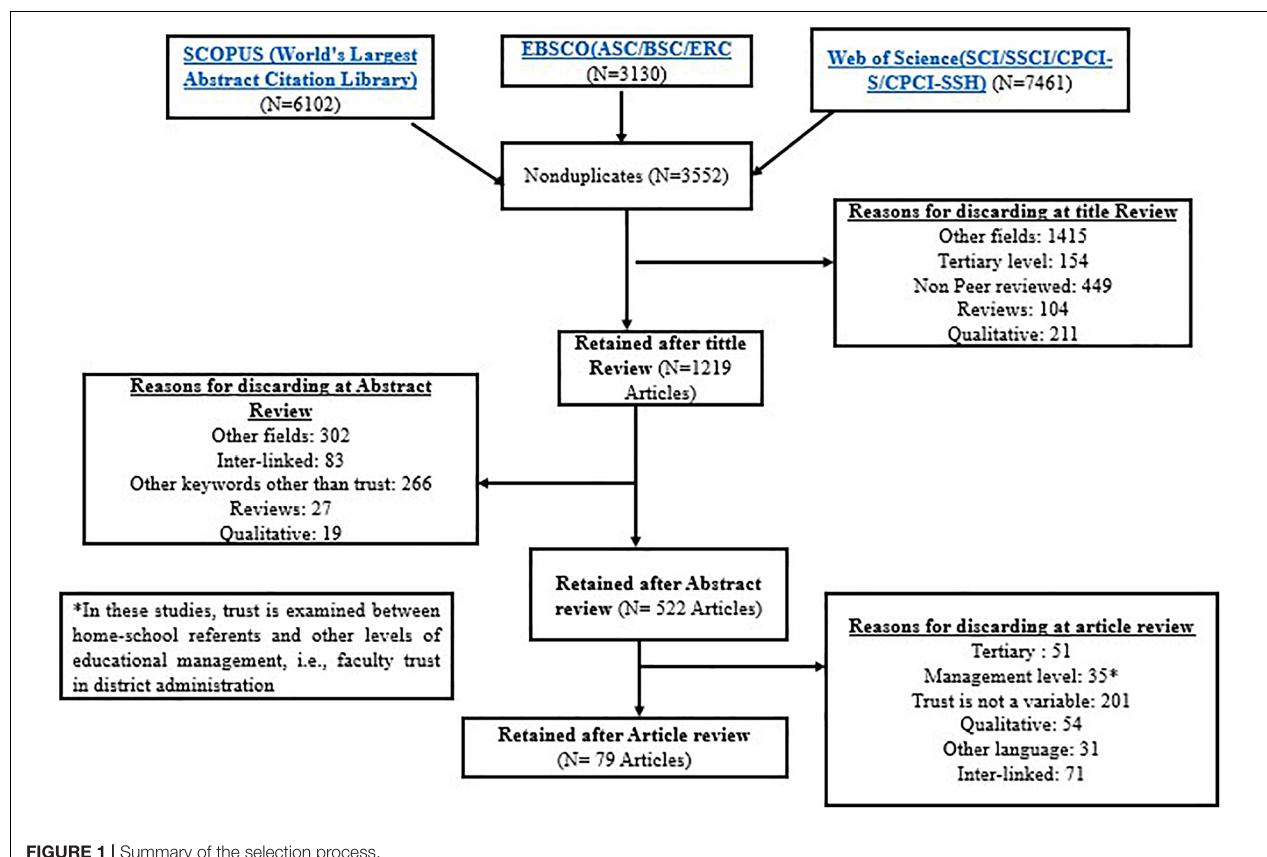
FIGURE 1 | Summary of the selection process.